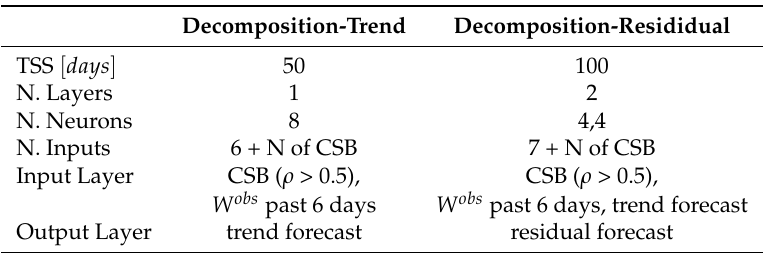
Table 1. Hybrid ANN parameters settings; TSS is the Training Set Size.